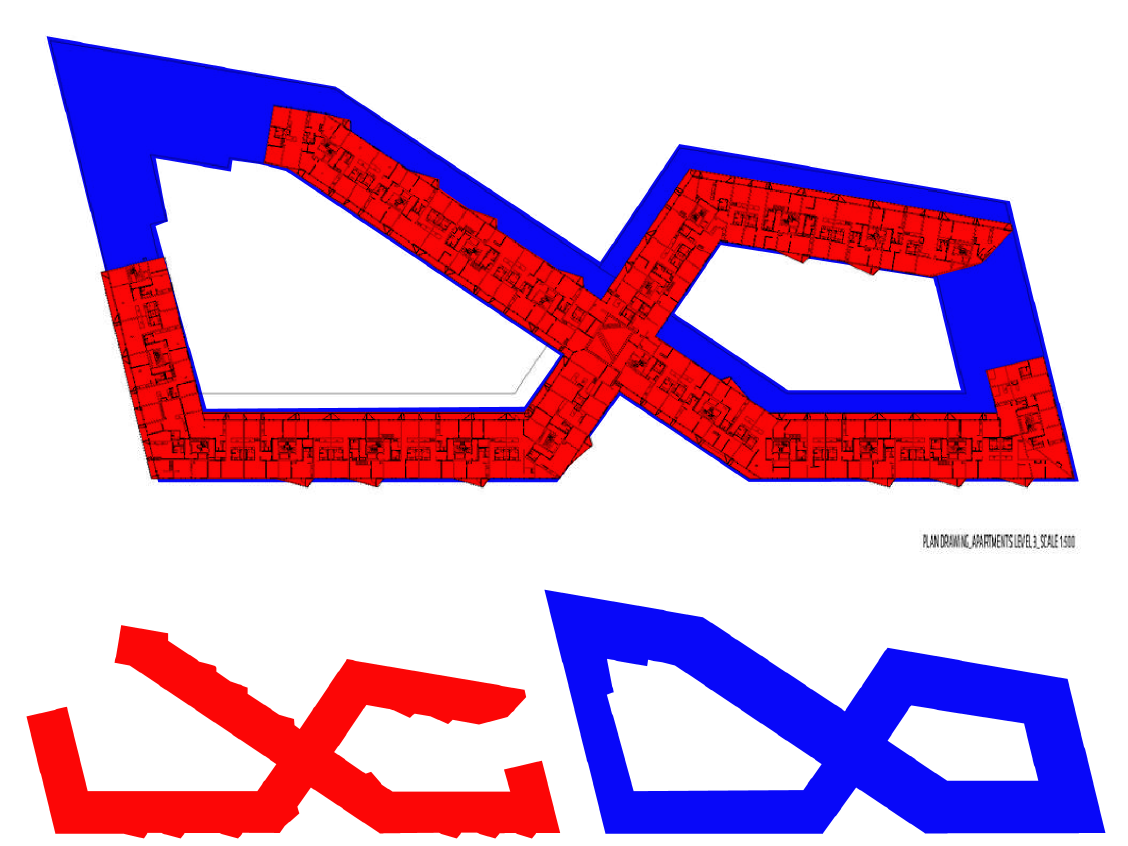
Figure 9. The main slab (blue) packs the apartments all together (red). Source: Adapted from Minner